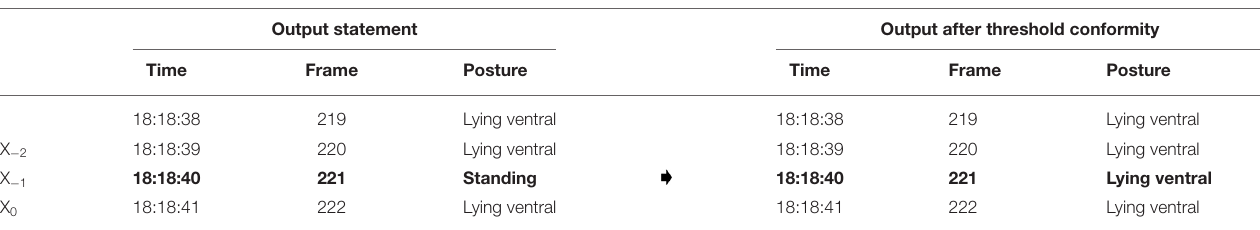
TABLE 4 | Example temporal threshold (One frame per second